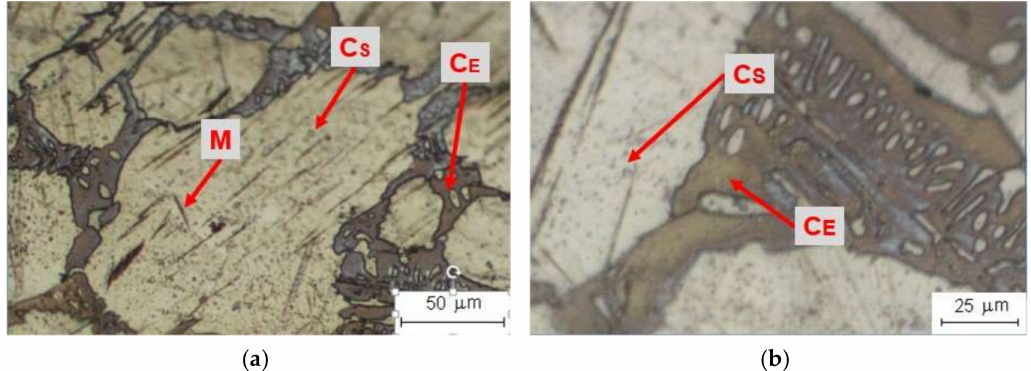
Figure 6. Murakami hot reagent: ( a ) general view at 200 × ; ( b ) detail at 500 × .